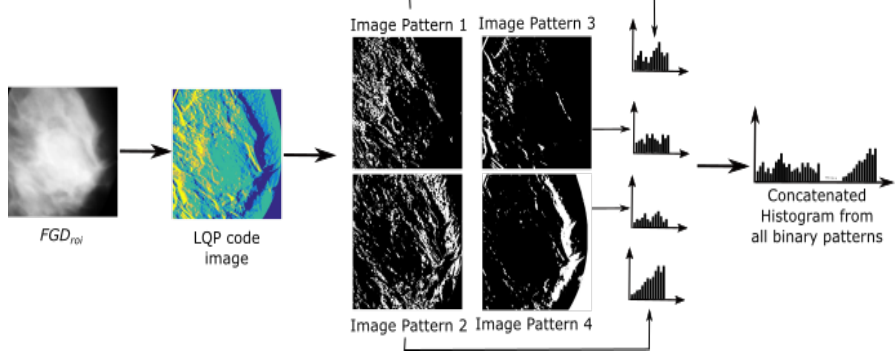
Figure 6. Four images of binary patterns generated from the LQP code